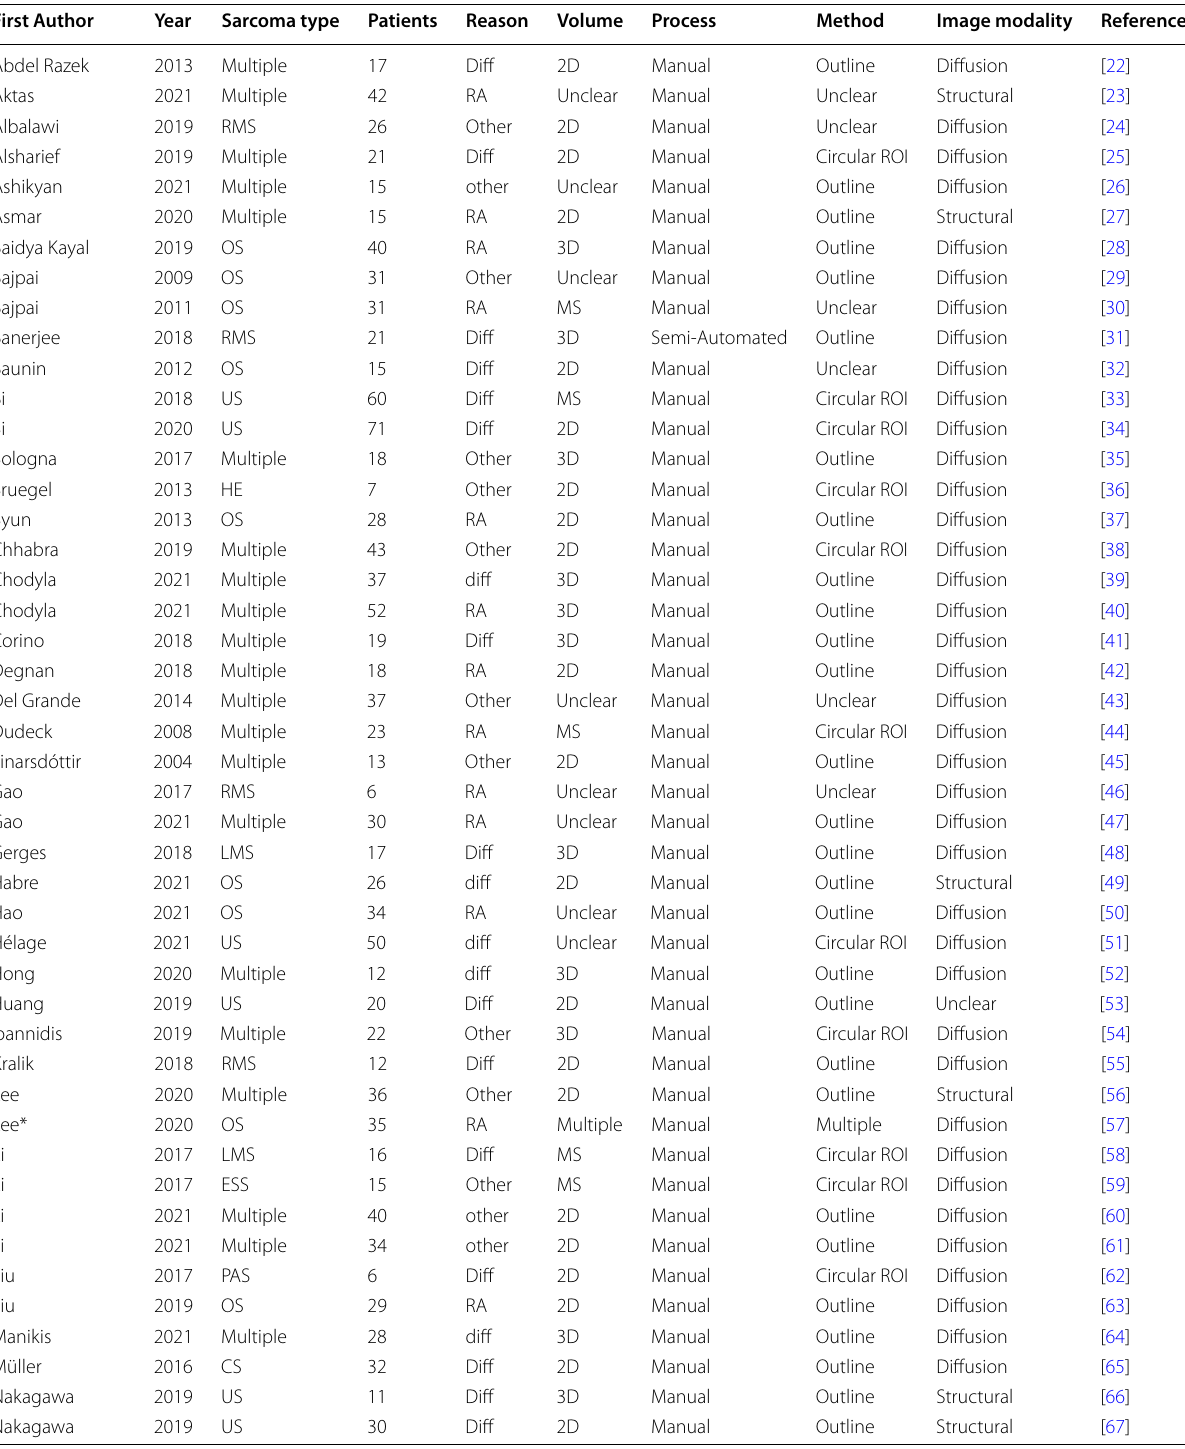
Table 1 The selected studies included patients with either rhabdomyosarcoma (RMS), osteosarcoma (OS), uterine sarcoma (US), chondrosarcoma (CS), leiomyosarcoma (LMS), pulmonary artery sarcoma (PAS), hepatic angiosarcoma (HA), endometrial stromal sarcoma (ESS), or multiple (soft tissue) sarcomas. Non-sarcoma patients not shown. The studies performed segmentation for either response assessment (RA), differentiation (diff), or other purposes. Studies marked with an asterisk (*) included multiple segmentation